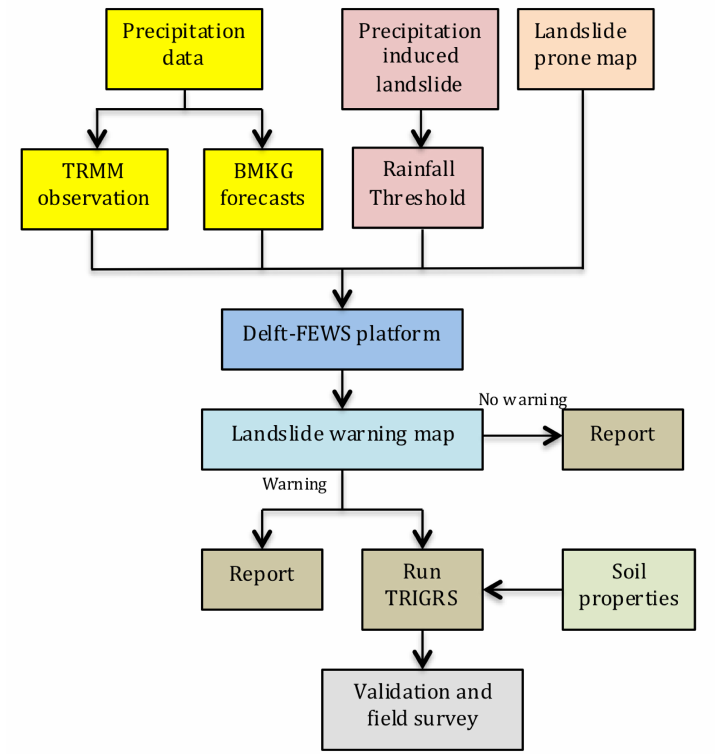
Figure 1. Flowchart data and method for developing the Indonesian Landslide Early Warning System